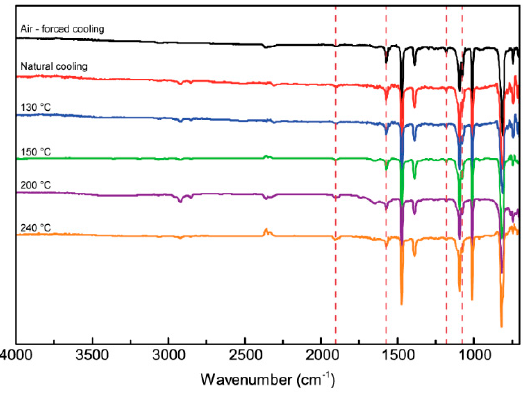
Figure 4. FTIR spectra of 3D-printed PPS samples.